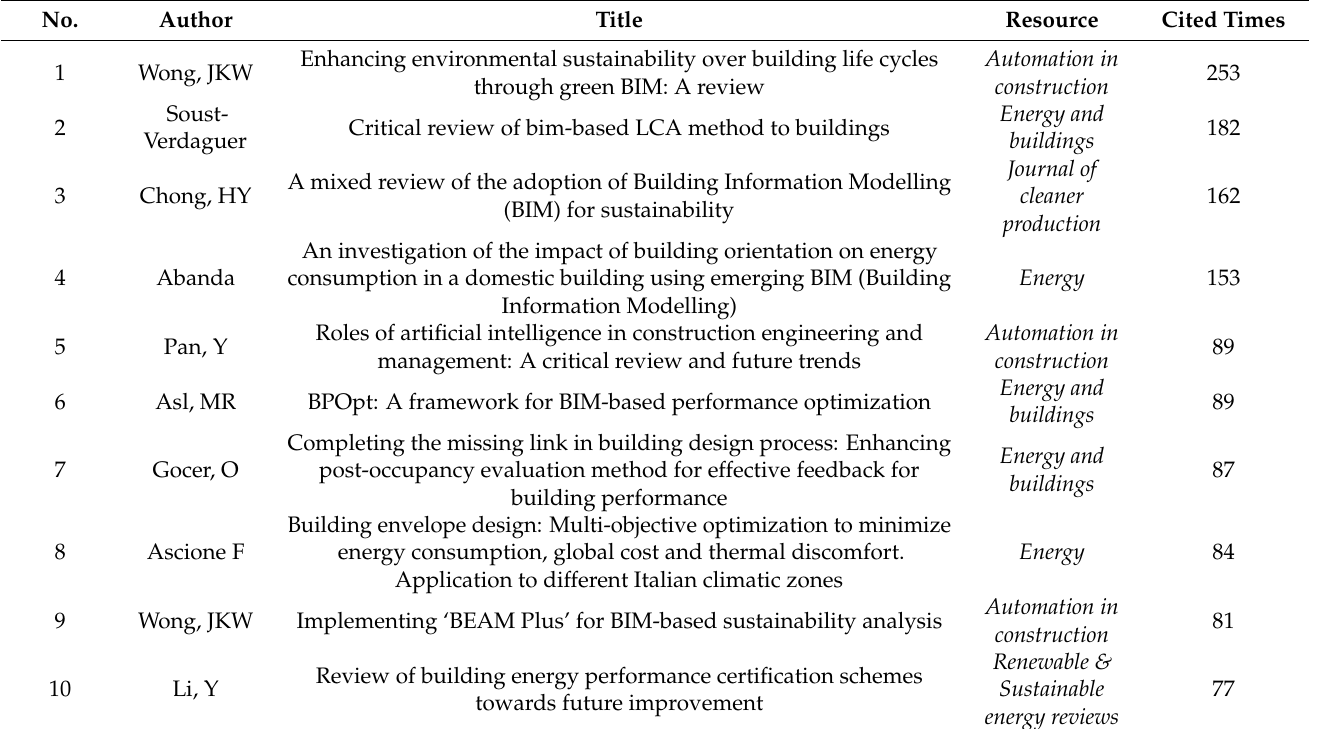
Table 5. The top 5 most cited